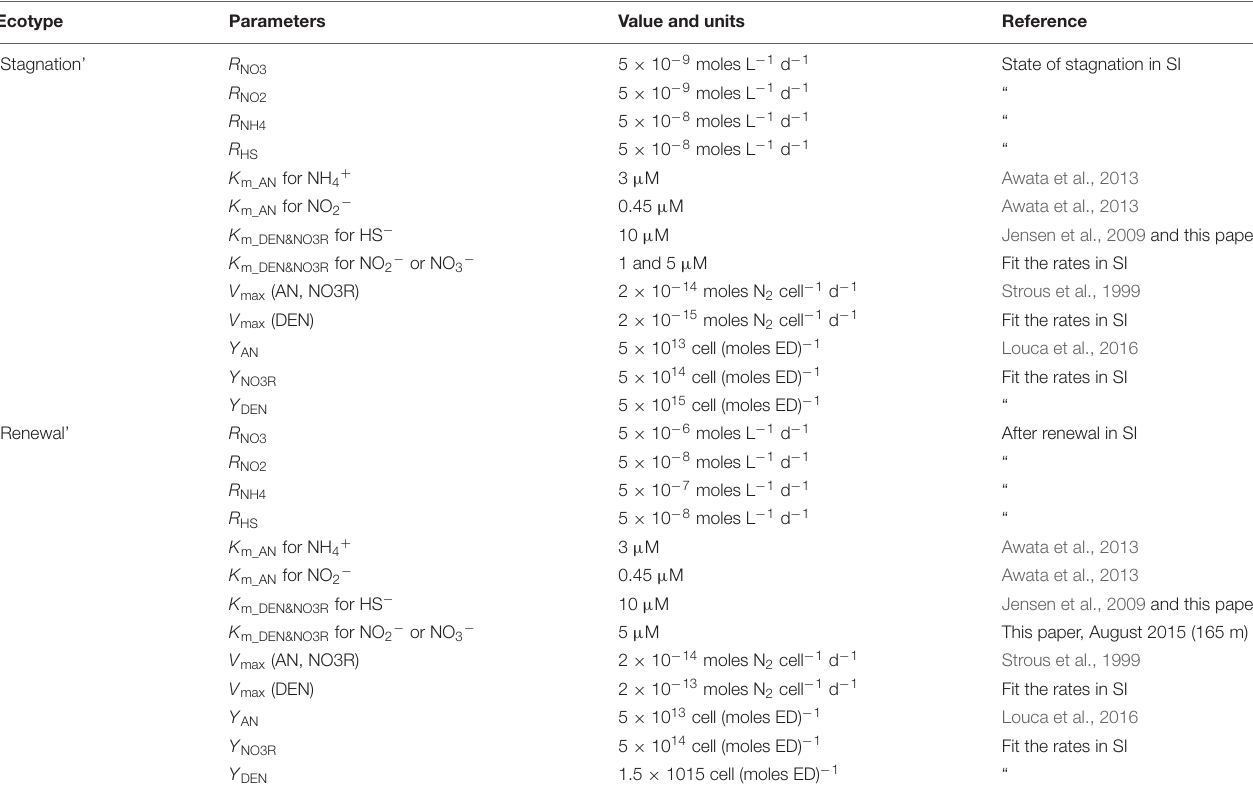
TABLE 3 | Parameters used in model for competition of NO 2 − between anammox and complete denitrification (see Figure 12 ).